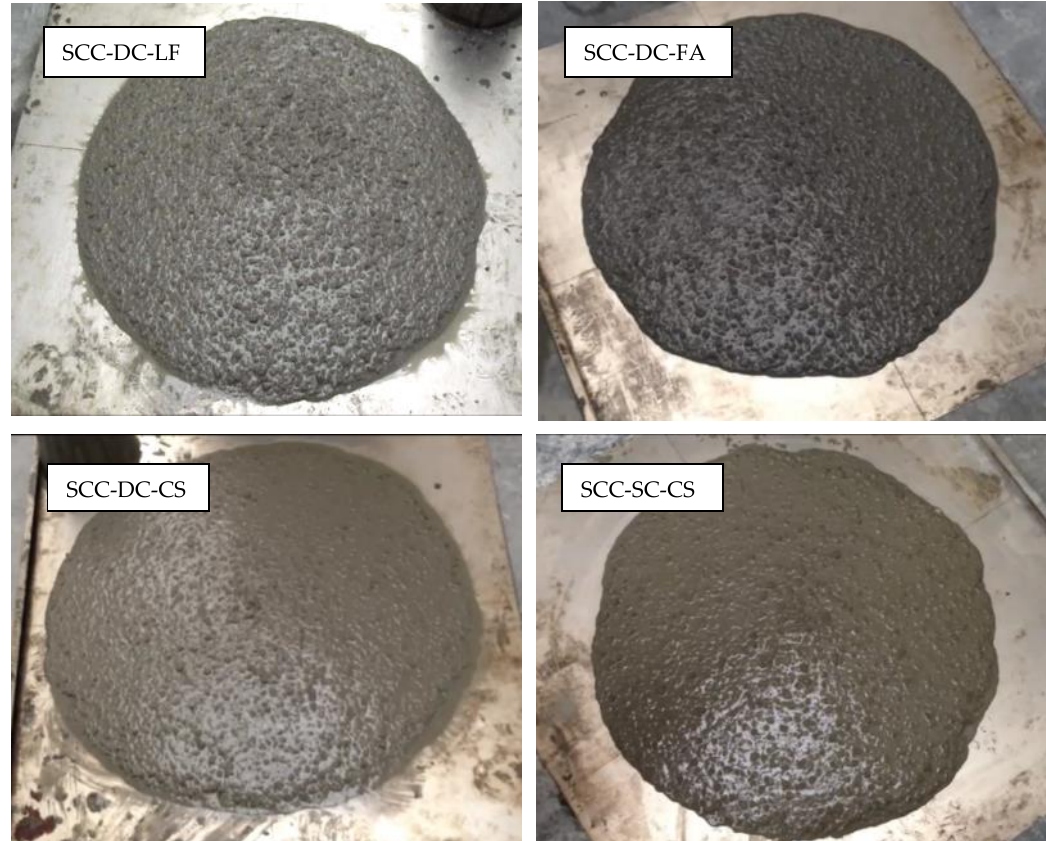
Figure 2. Slump disks detail of all mixes.